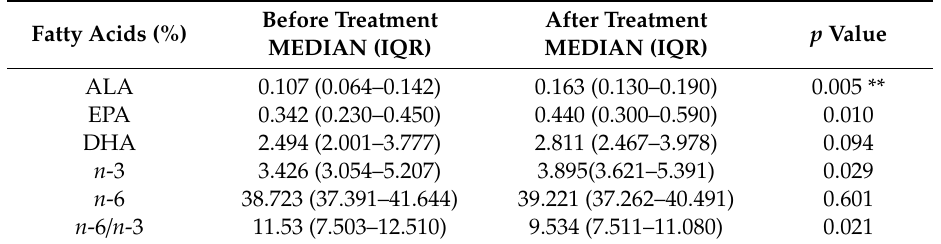
Table 6. Fatty acids in plasma phospholipids of study participants before and after the intervention. Fatty Acids